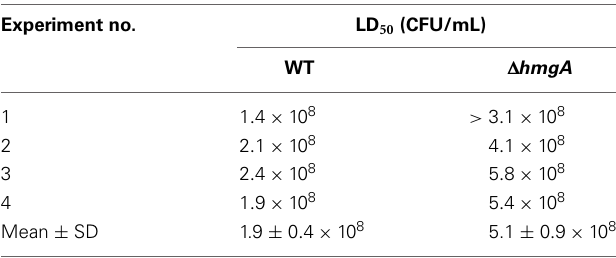
Table 1 | V. campbellii BAA-1116 and (cid:2) hmgA Penaeus monodon